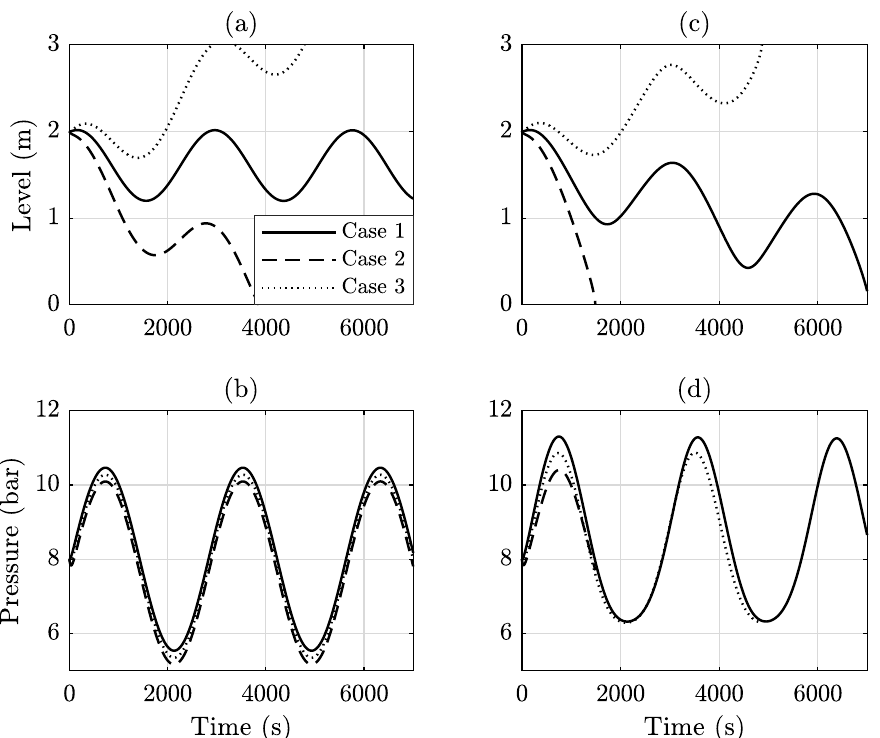
Figure 5. Simulation of the linear and nonlinear plants for different valve openings with slugs.